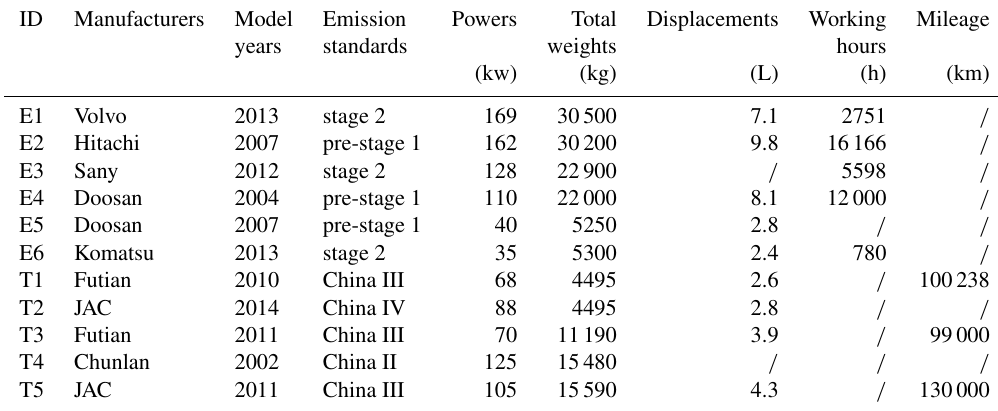
Table 1. Specifications of tested excavators and trucks.